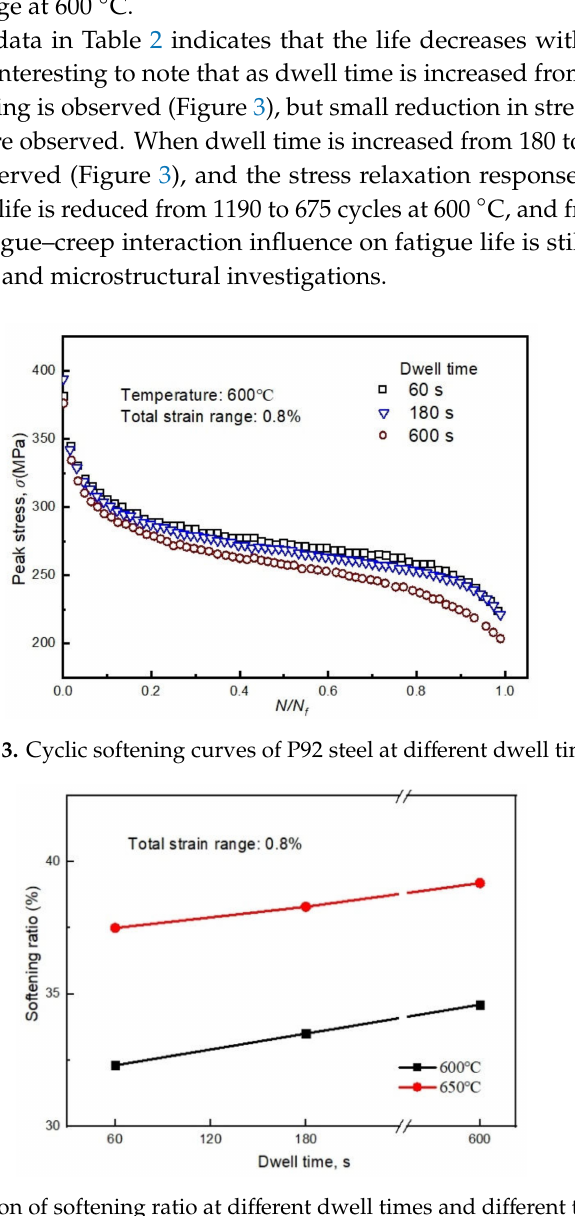
Figure 4. Variation of softening ratio at di ff erent dwell times and di ff erent